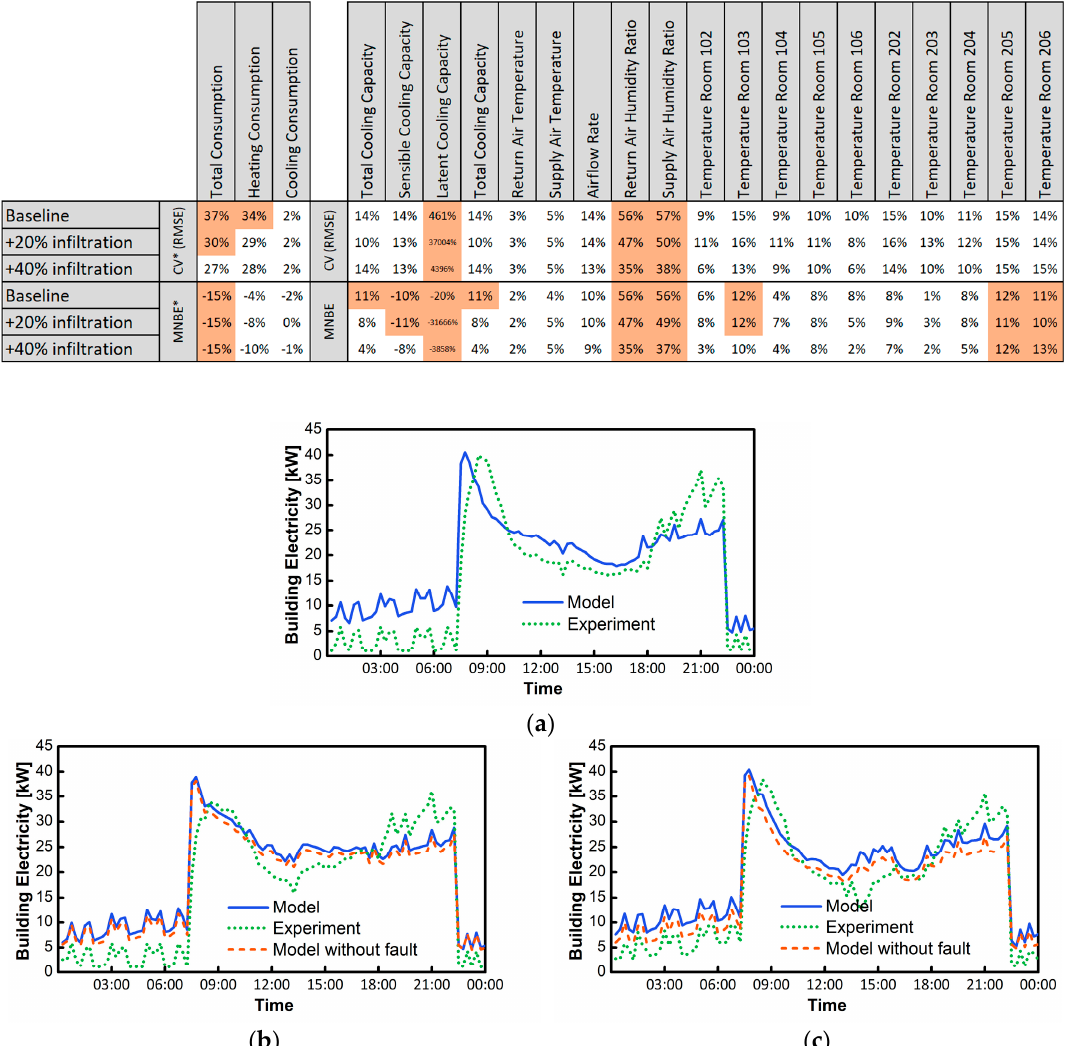
Table 10. CV (RMSE) and NMBE Calculations for Detailed Model Outputs: Excessive Infiltration Through the Building Envelope.